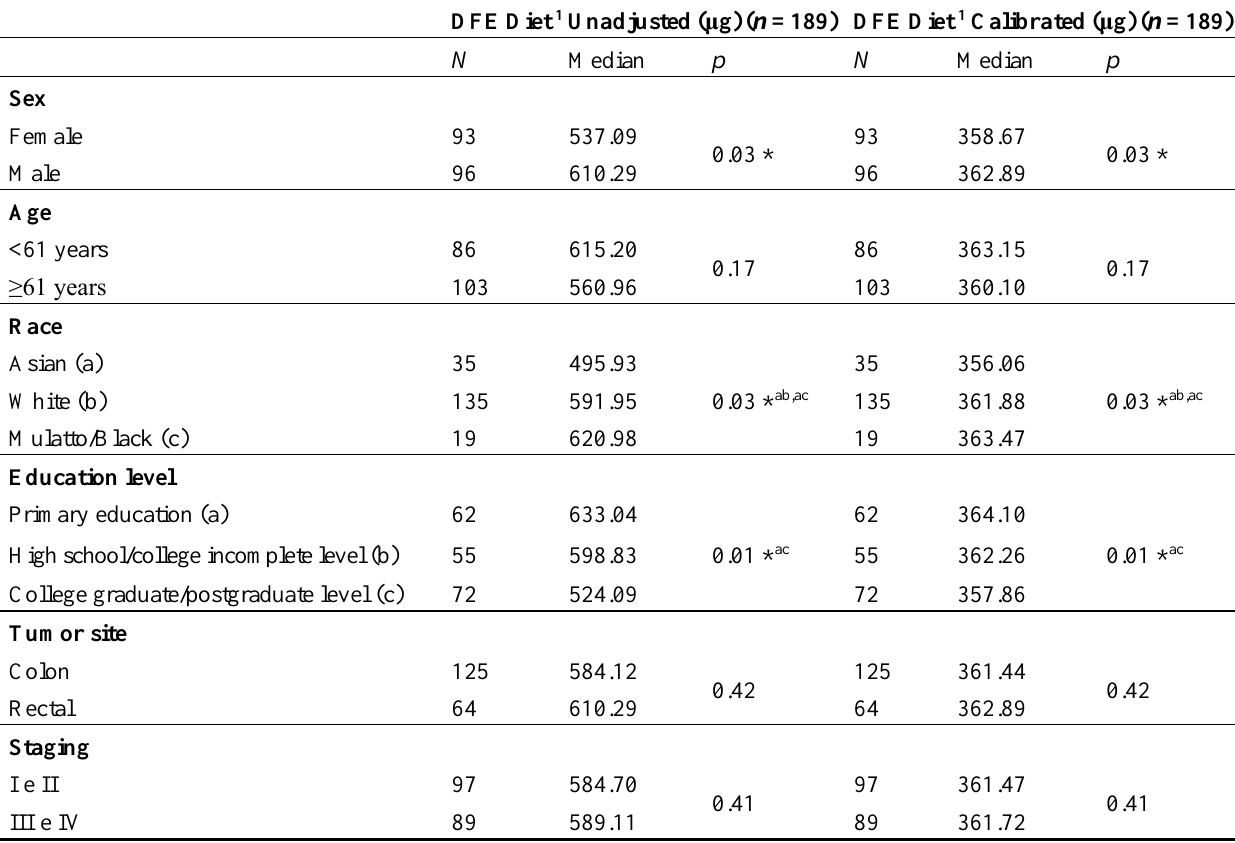
Table 3. Median comparison of DFE from unadjusted diet data and calibrated diet DFE according to sociodemographic and clinical characteristics in the pretreatment of patients for colorectal